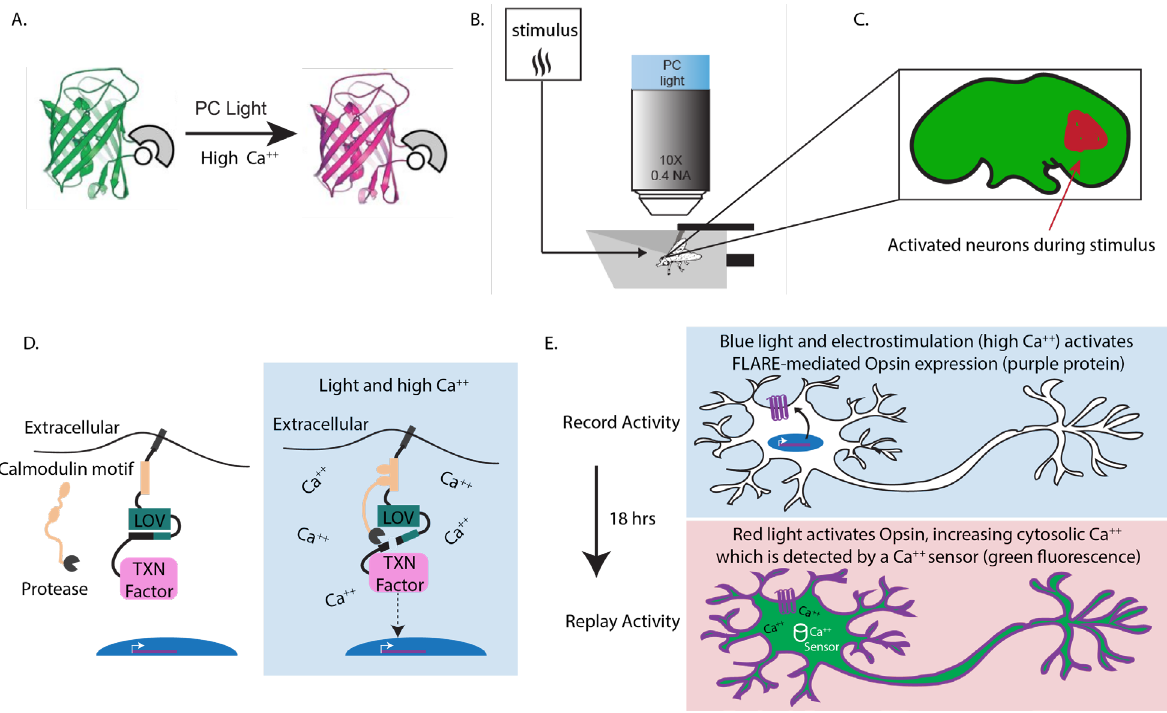
Figure 1: Recent top-down synthetic biology approaches to study biology. A. Schematic representation of CaMPARI technique. B. Proposed experimental design to use CaMPARI to study activity dependent neuronal circuitry in Drosophila . C. Cartoon of Drosophila brain illustrating potential result from CaMPARI study depicted in B. As is illustrated, the entire brain is fluorescently green however, upon activation of CaMPARI specific regions of the brain responsible for a response to a stimulus are switched to red fluorescence emission. D. Schematic of the FLARE technology. E. Proposed experimental strategy illustrating FLARE’s record and replay ability in neurons. Panels for this figure were adapted from Fosque et al 2015 (panels A-C) [27] and Wang et al 2017 (panels D&E)